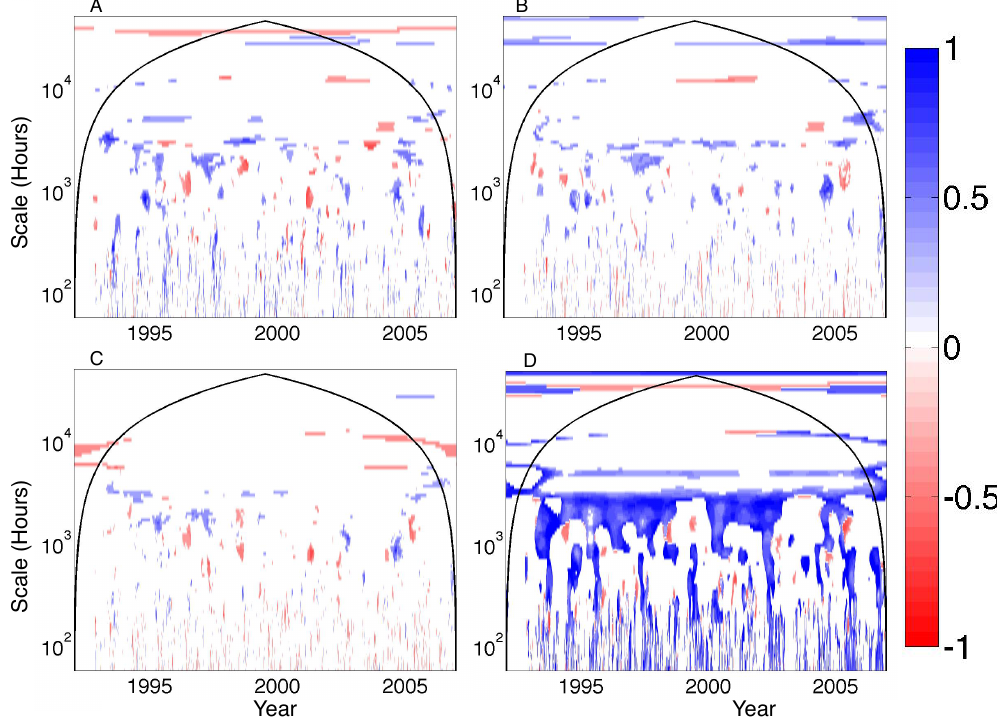
Fig. 5. The ratio of significant wavelet coherence for different model attributes for the net ecosystem exchange (NEE) observations at the Harvard Forest (US-Ha1) following Eq. (1). Areas of dark blue represent times and scales where all models that include prognostic phenology (A) , the NEE calculation as GPP minus ER (B) , the inclusion of nitrogen (C) , and a model that used data assimilation (LoTEC, D ) are significantly related to NEE observations, and when none of the opposing model strategy listed in Table 2 is significant. Areas of dark red represent periods when the opposite